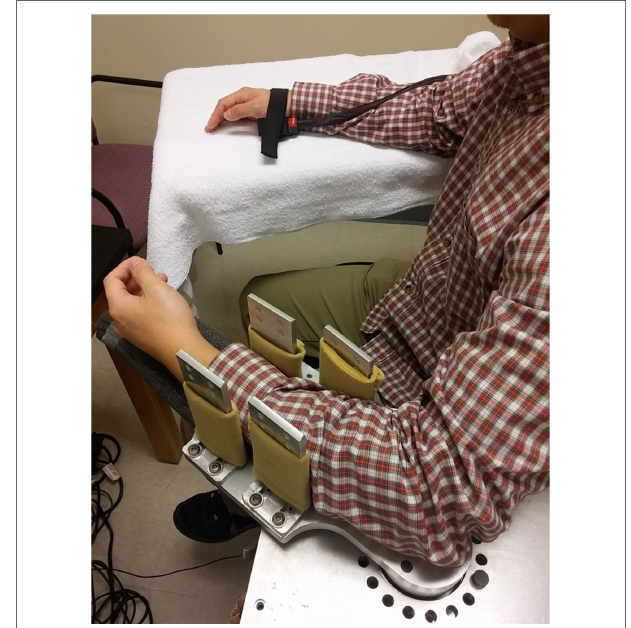
FigUre 1 | experimental setup